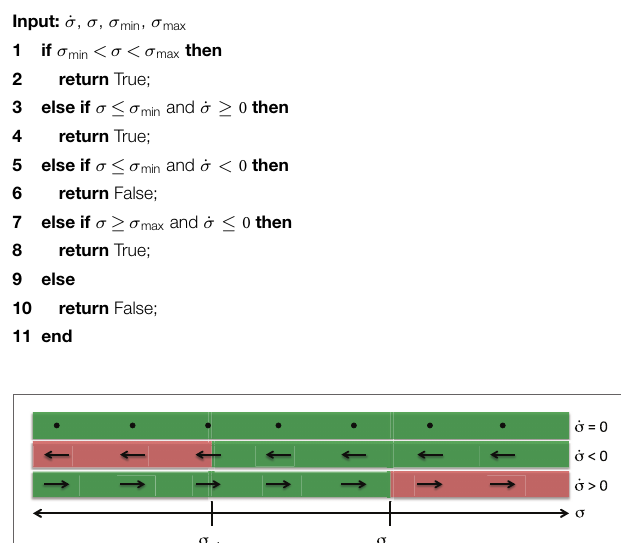
ALGORITHM 1 | The Boolean function in_T_RC .